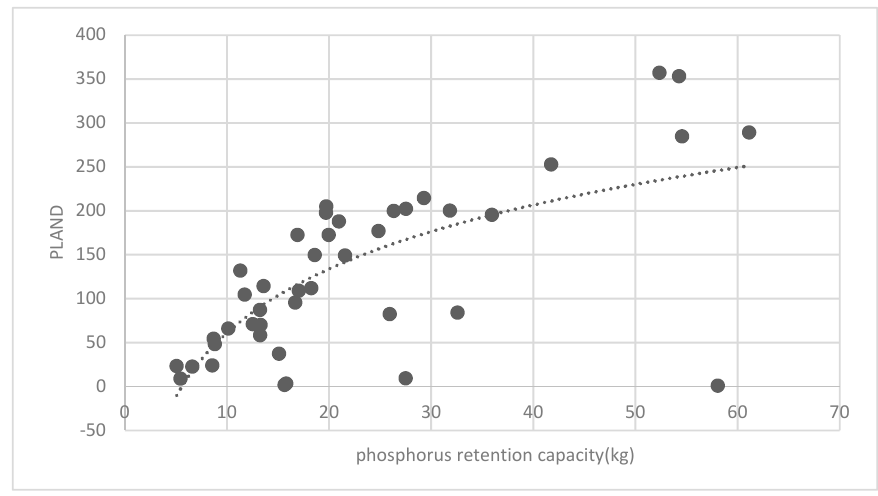
Figure 22. Association between the forest land PLAND index and phosphorous retention capacity.